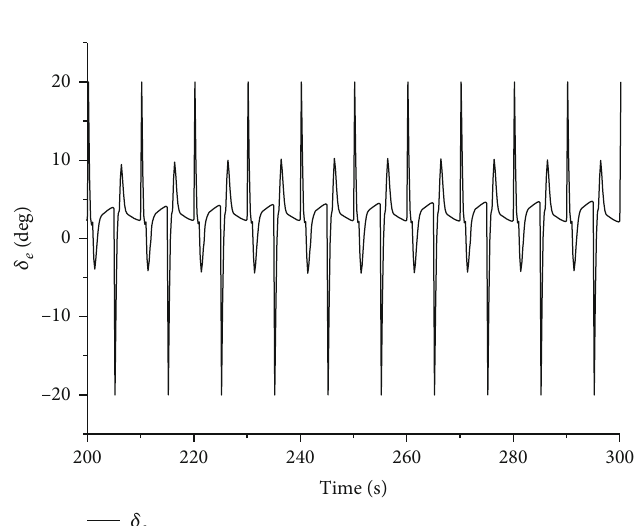
Figure 22: Pitch with attitude control.